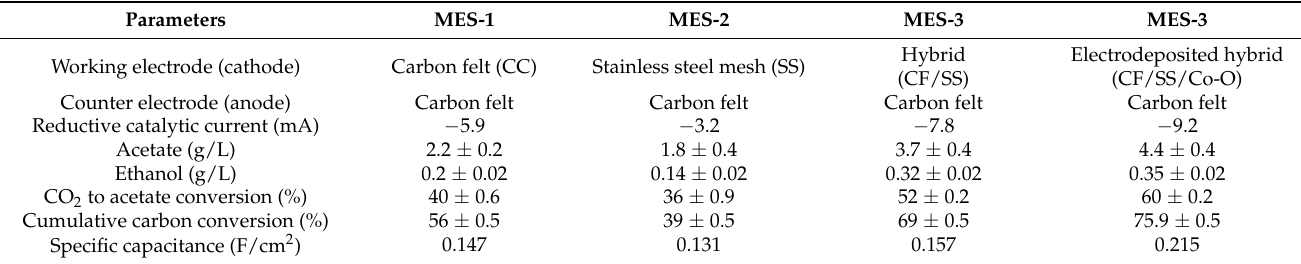
Table 2. Comparative efficiency of four different based biocathodes MES configured.